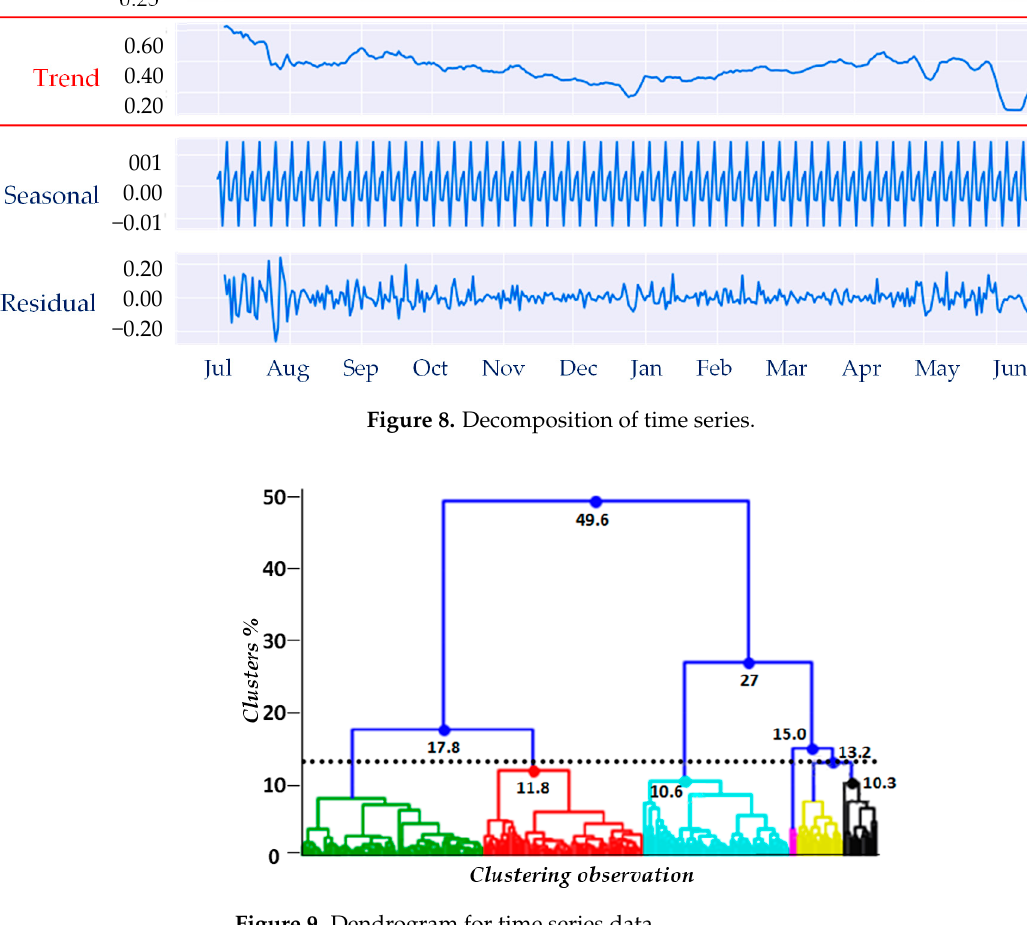
Figure 8. Decomposition of time series.